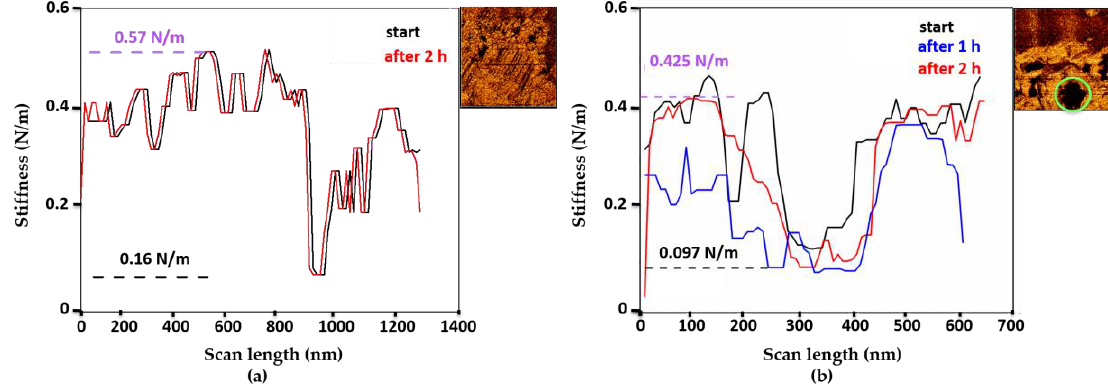
Figure 7. Stiffness profiles of a microMOF ( − ) particle upon incubation for 2 h in water ( a ) and in ( b ) PBS.